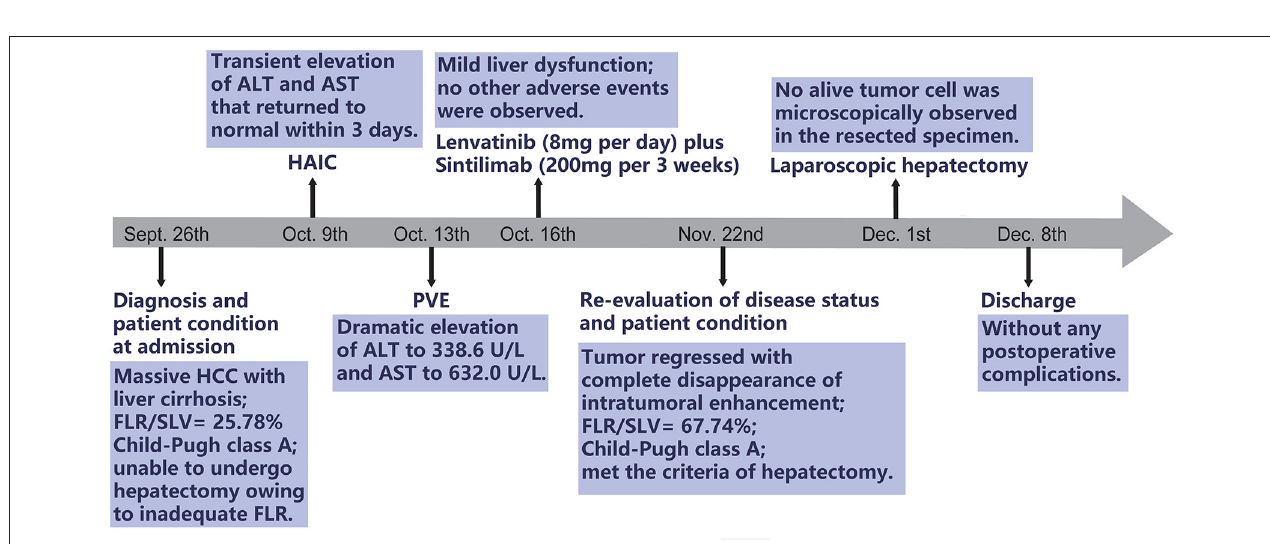
FIGURE 5 | The timeline of clinical events. HCC, hepatocellular carcinoma; FLR, future liver remnant; SLV, standard liver volume; HAIC, hepatic artery infusion chemotherapy; ALT, alanine transaminase; AST, aspartate aminotransferase; PVE, portal vein